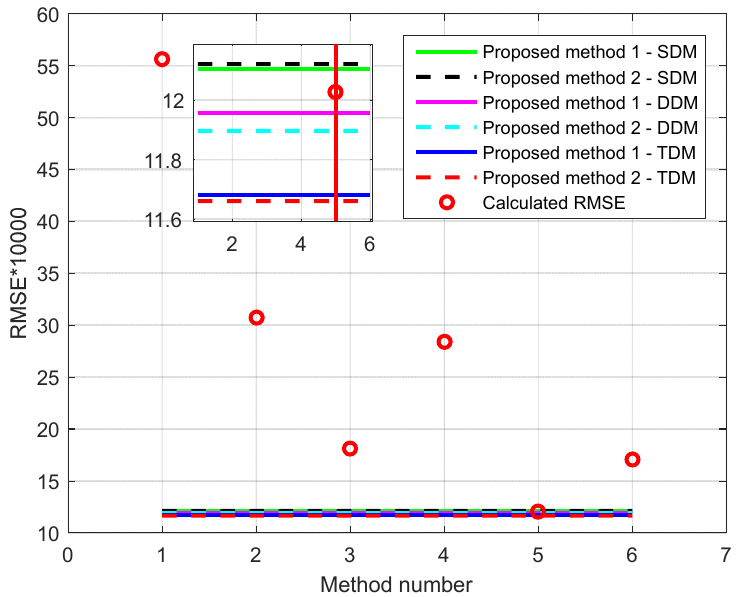
Figure 3. RMSE comparison for methods used to estimate the Solarex MSX–60 PV solar module parameters.